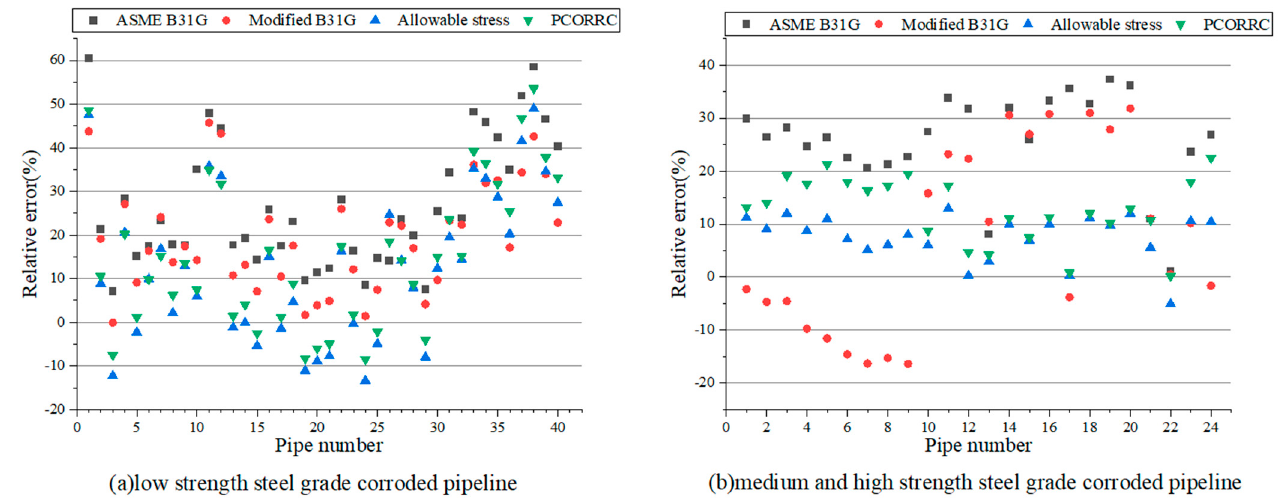
Figure 10. Different methods to calculate relative error of failure pressure of: ( a ) low-strength steel grade corroded pipeline; ( b ) high-strength steel grade corroded pipelines.